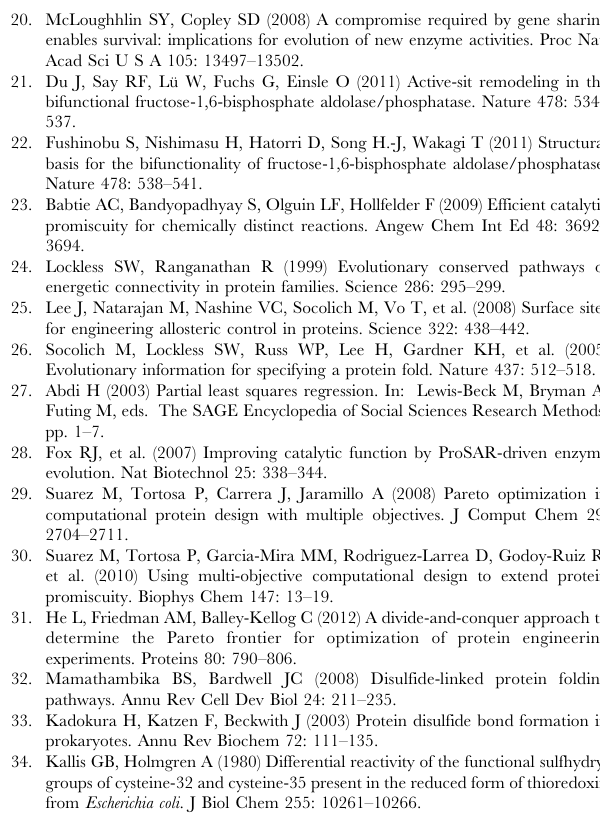
shown here with closed circles. Figure S2 Determination of the reductase activity of thioredoxin variants. Respresentative plots of absorbance at 650 nm versus time for the reduction of insulin catalyzed by thioredoxins. Profiles for the wild-type thioredoxin from E.coli and two variants are shown. Figure S3 Determination of the reductase activity of thioredoxin variants. Plots of derivative of absorbance versus time corresponding to the profiles shown in Figure S2. The activity value for each variant at the concentration shown is calculated as the maximum value of dA 650 /dt. Figure S4 Determination of the reductase activity of thioredoxin variants. Specific activity is determined from the slopes of plots of activity (maximum value of dA 650 /dt) versus protein concentration. Several representative examples are shown, including wild-type thioredoxin from E.coli and several variants. Figure S5 Determination of the catalysis of oxidative folding activity of thioredoxin variants. Plots of recovered RNase activity from fully reduced protein versus thioredoxin variant concentration. Specific activity is calculated as the slope of these plots. Recovered RNase activity is measured by the initial rate of the change of the absorbance at 288 nm that accompanies